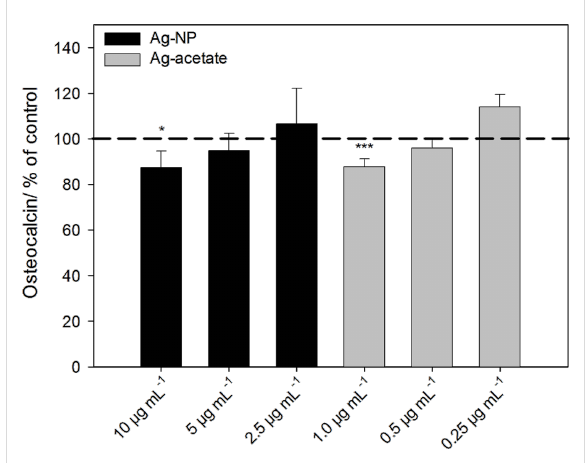
Figure 8: Release of the osteogenic differentiation marker osteocalcin after incubation of hMSCs with Ag-NP/Ag + ions. The data are expressed as the mean ± SD ( n = 7 independent experiments), given as the percent of the control (osteocalcin 15.6 ± 6 ng·mL − 1 ; cells cultured without silver, dashed line). The asterisks (*) indicate signifi- cant differences with respect to the control (* p < 0.05, *** p < 0.001).